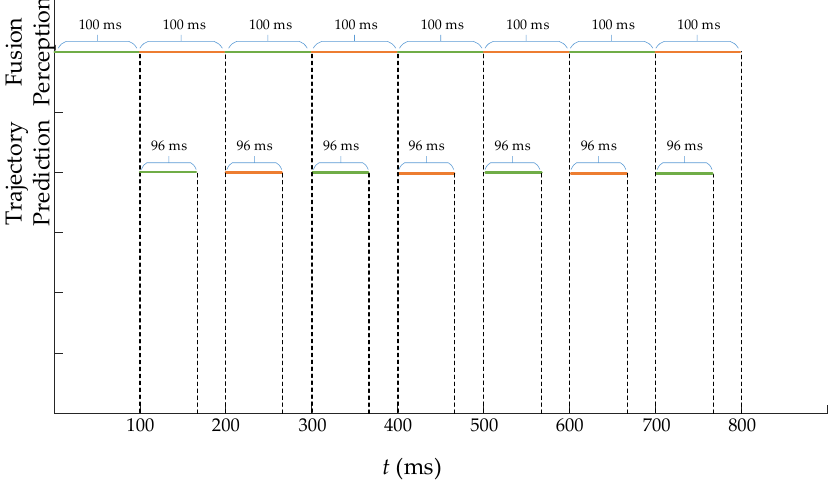
Figure 13. Analysis of the calculation latency of the improved LSTM model.